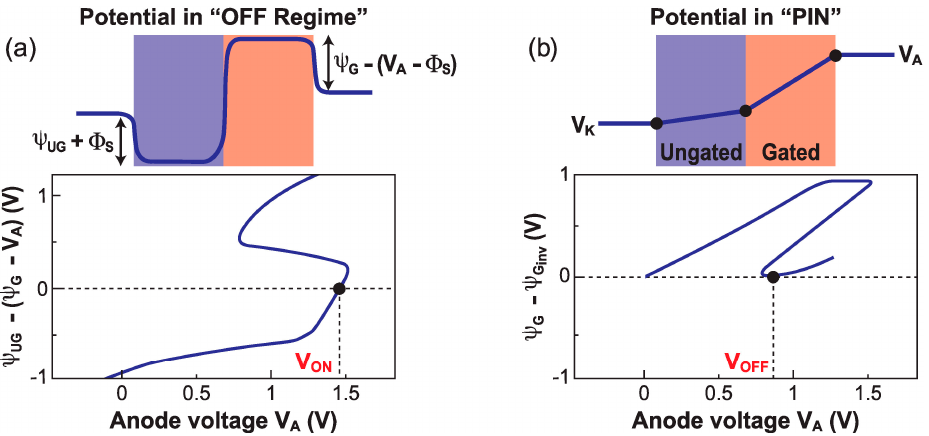
Figure 12. Schematic view and potential variation vs. anode voltage in ( a ) the I OFF regime and ( b ) PIN regime, showing the position of the switching voltages V ON and V OFF (adapted from [29]). Conversely, the turn-off voltage V OFF is the boundary voltage between the negative differential resistance and PIN regimes (point C in Figure 9). The device turns off when V A is sufficiently low to allow the gate to regain control of the gated region, as shown in Figure 12b. The lower limit of the PIN regime occurs when the potential difference Ψ G - Ψ Ginv reaches zero. To obtain an analytical expression for Ψ G , Ohm’s law can be ap- plied to the gated and ungated segments, finally leading to V OFF :